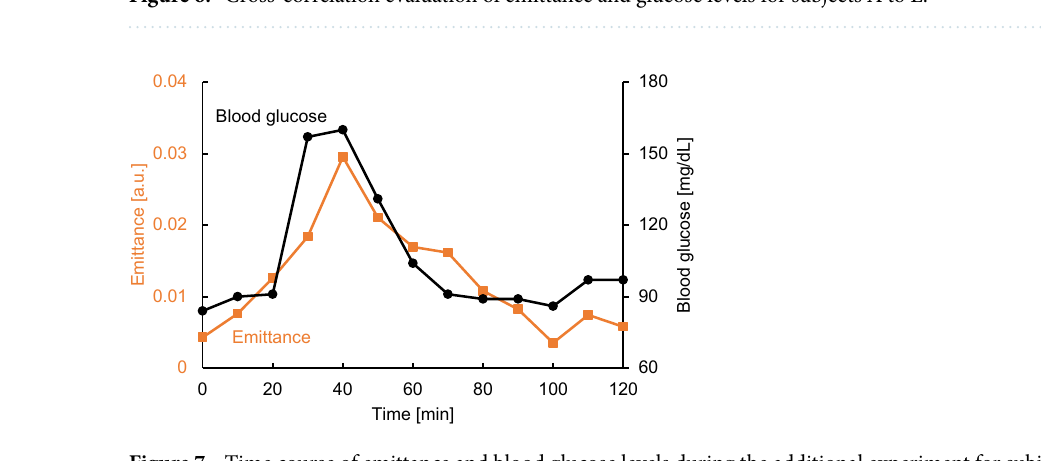
Figure 6. Cross-correlation evaluation of emittance and glucose levels for subjects A to E.